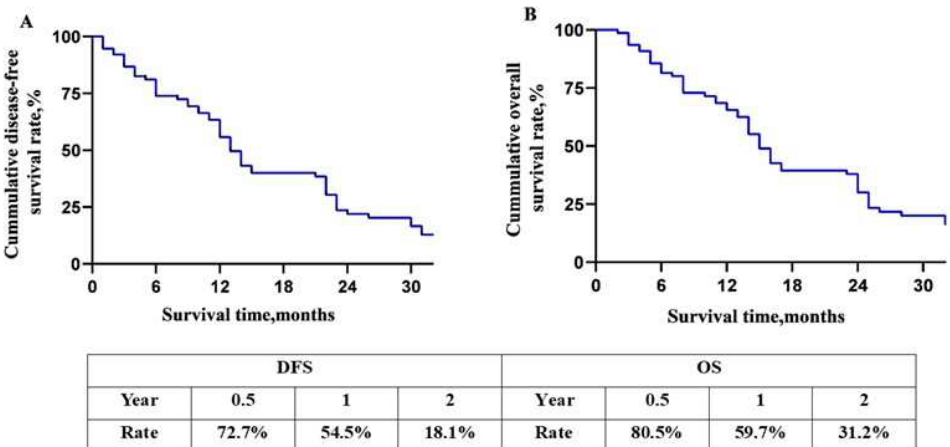
Figure 3. Overall long-term prognosis of the patients. ( A ) Disease-free survival curve of patients with BRPC; ( B ) overall survival curve of patients with BRPC. Abbreviations: DFS, disease free survival. OS, overall survival.